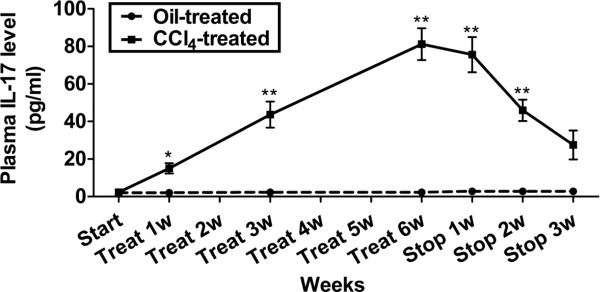
Change of IL-17 in the pathogenesis of mouse liver injury induced by CCl4 injection. Solid line and dash line showing the dynamic change of plasma IL-17 in the pathogenesis of mouse liver injury induced by CCl4 injection. *p < 0.05, **p < 0.01 vs oil-treated group. Start, the time when oil or CCl4 injection started; Treat, oil or CCl4 treatment; Stop, stopped oil or CCl4 injection.